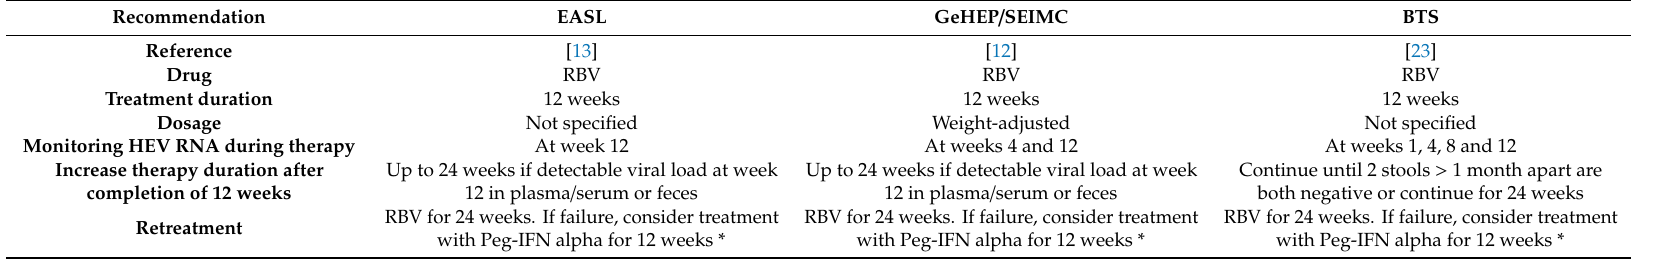
Table 1. Treatment recommendations for chronic hepatitis E virus infection according to clinical guidelines.